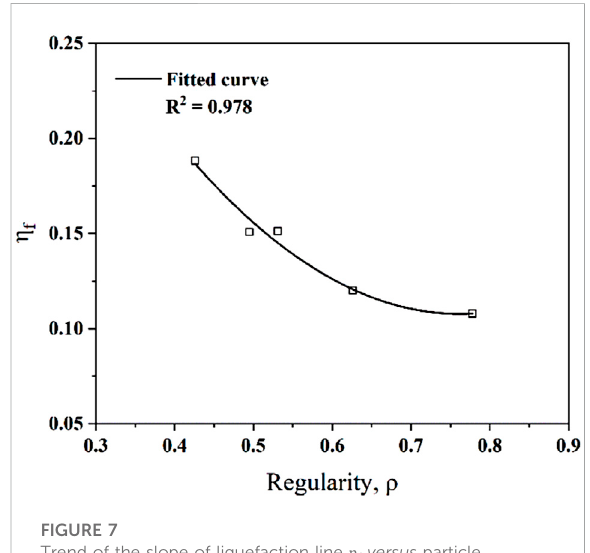
FIGURE 7 Trend of the slope of liquefaction line η f versus particle